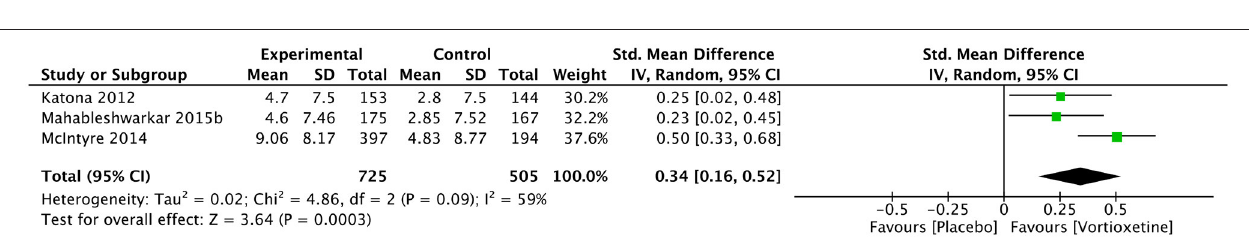
FIGURE 4 | Forest plot of comparison on vortioxetine vs. placebo (A) Response, (B) remission, (C) tolerability, and (D) acceptability.